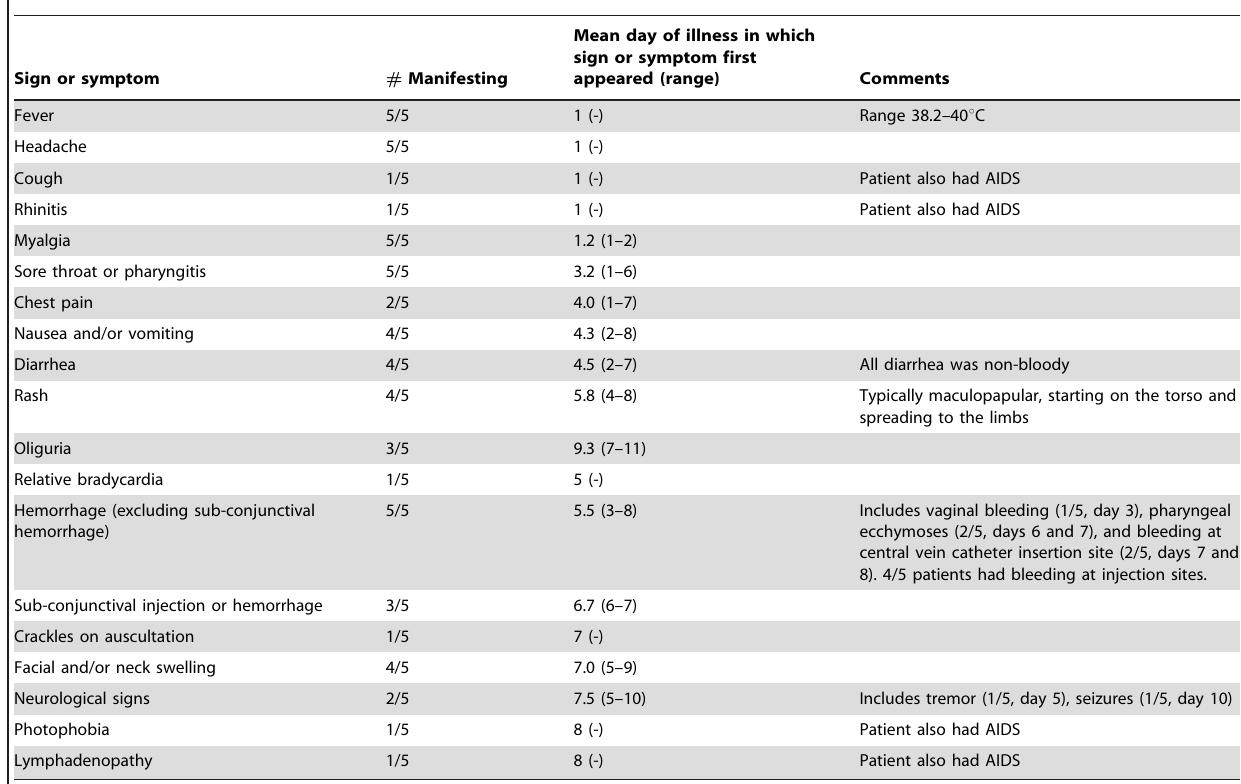
Table 1. Clinical signs and symptoms in 5 patients with Lujo hemorrhagic